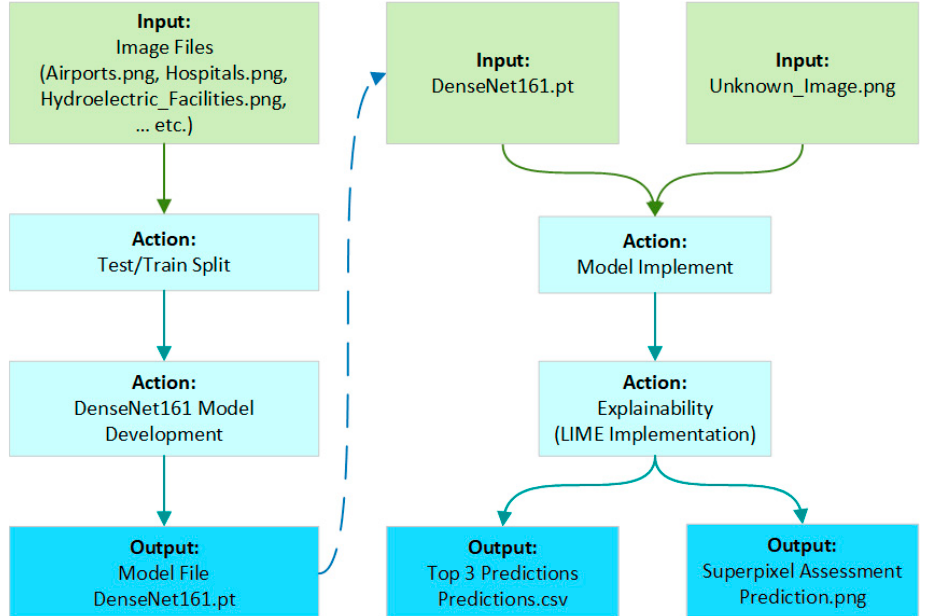
Figure 1. Modeling and analysis pipeline showing the flow of information from image data inputs to explainable predictions, with example input and output data files.